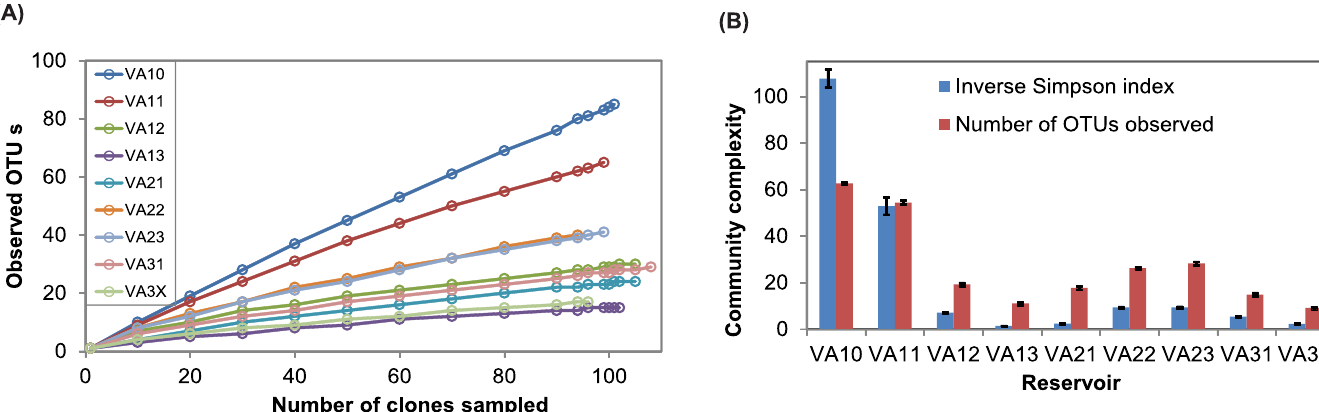
Fig 3. α -diversityof microbial communities in eight reservoirsand one adjacent stream.A . Rarefactioncurves of operationaltaxonomicunits (OTUs) in clone sequencesamongthe reservoirs. B . Inverse Simpson diversity index and number of observedOTUs in the reservoirs.